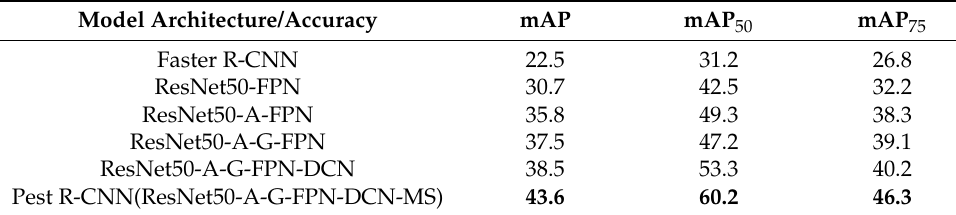
Table 4. The object detection accuracy comparison of the ablation studies. Model Architecture/Accuracy